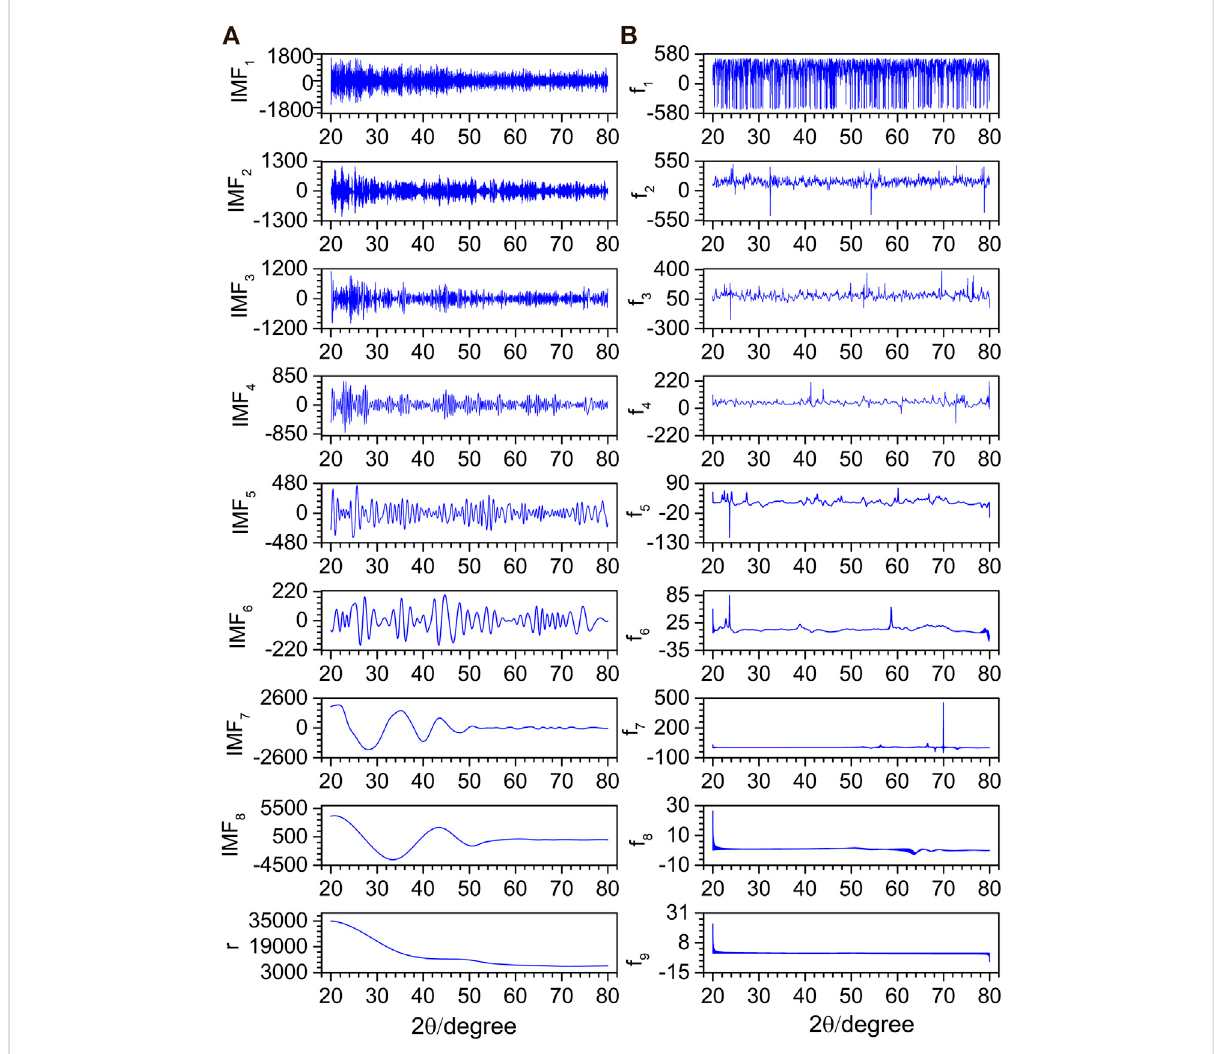
FIGURE 8 EMD decomposition results (A) and their corresponding instantaneous frequencies (B) for the XRD